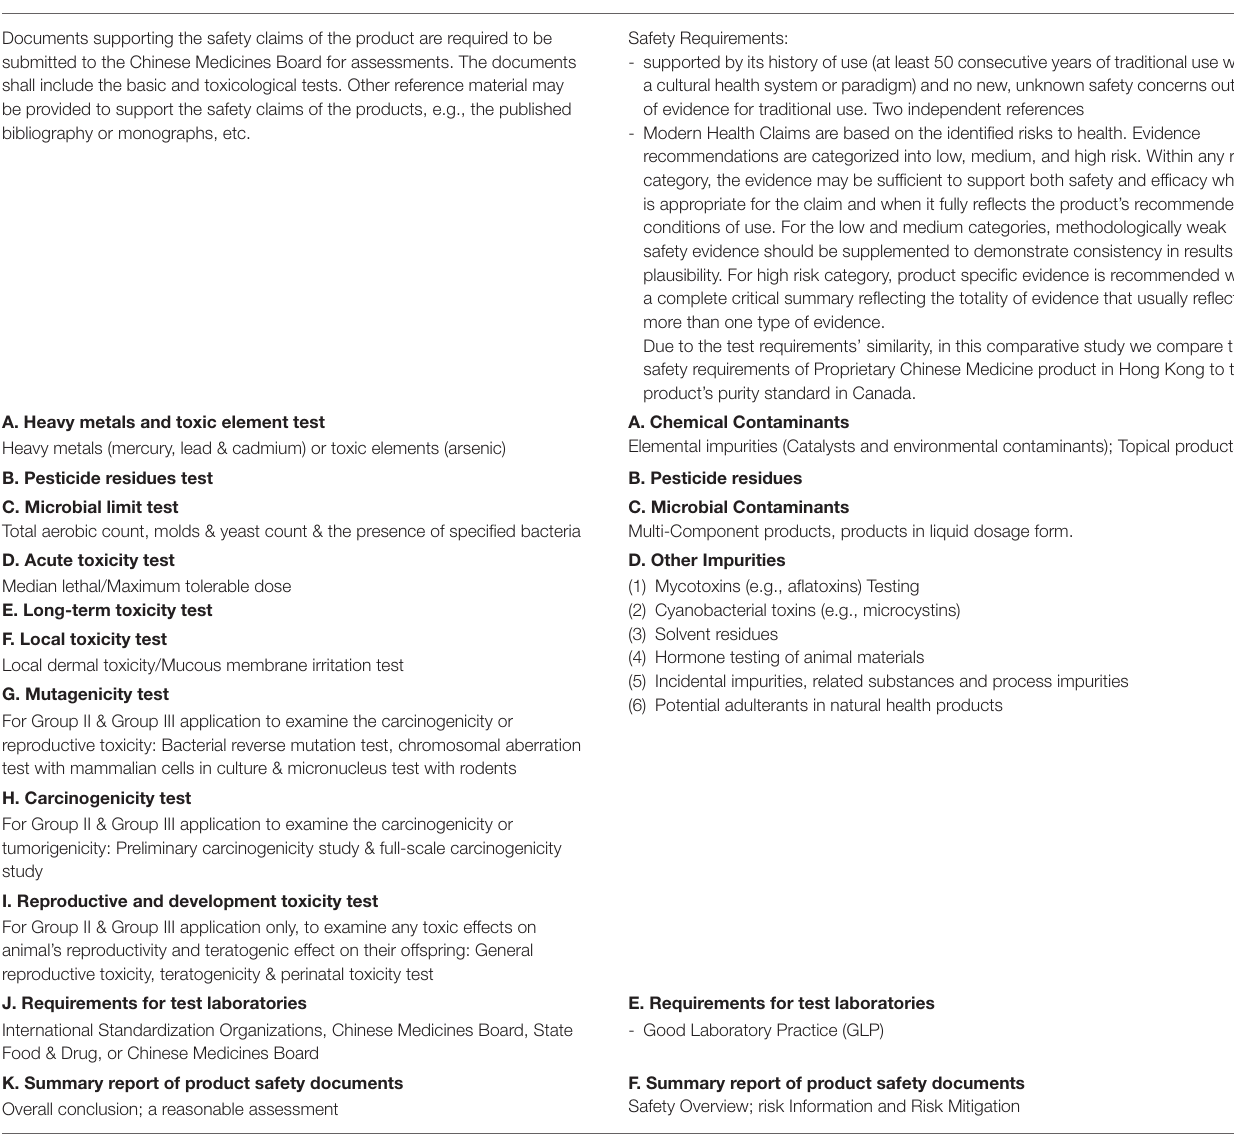
TABLE 3 | The safety requirements and purity standards (under Quality Requirements’ guidelines) of proprietary Chinese medicines in Hong Kong and Canada respectively (11, 12). Hong Kong (Safety requirements) Canada (Purity